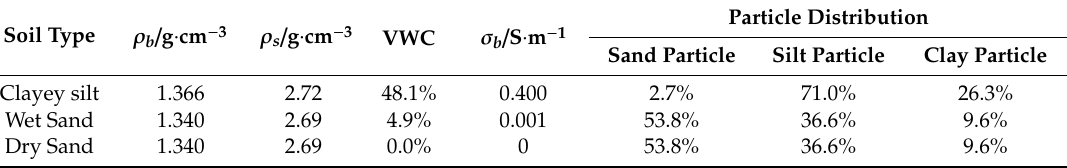
Table 2. Parameters of the backfilled